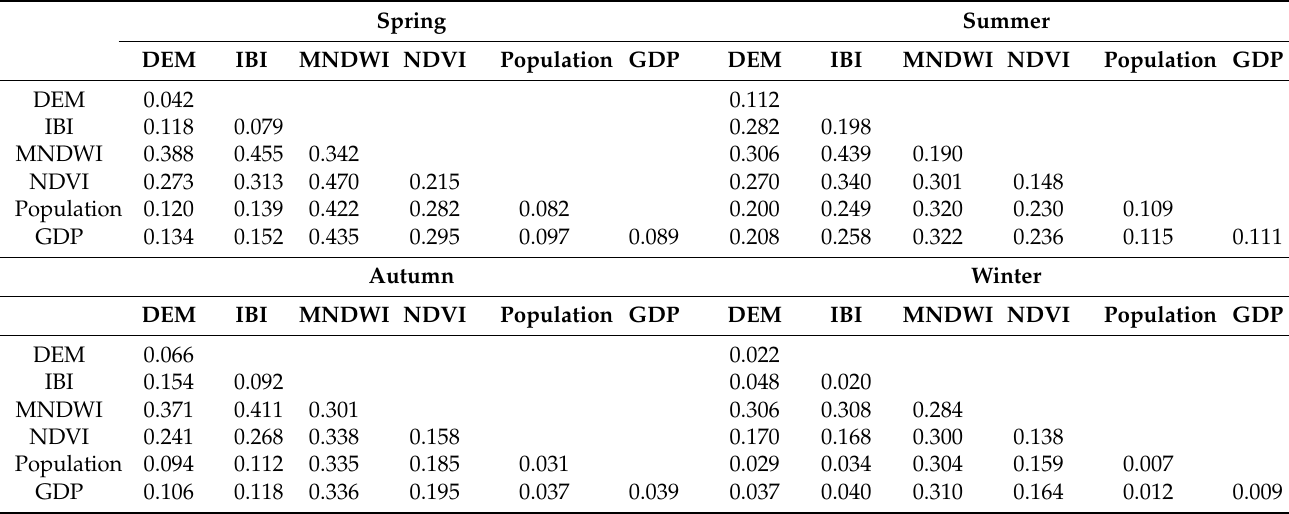
Figure 6. The q statistic of the factor detection on Wuhan’s LST for the four seasons of the year. Table 3. Interactions between the driving factors of Wuhan’s LST in the four seasons of the year as measured by the interaction